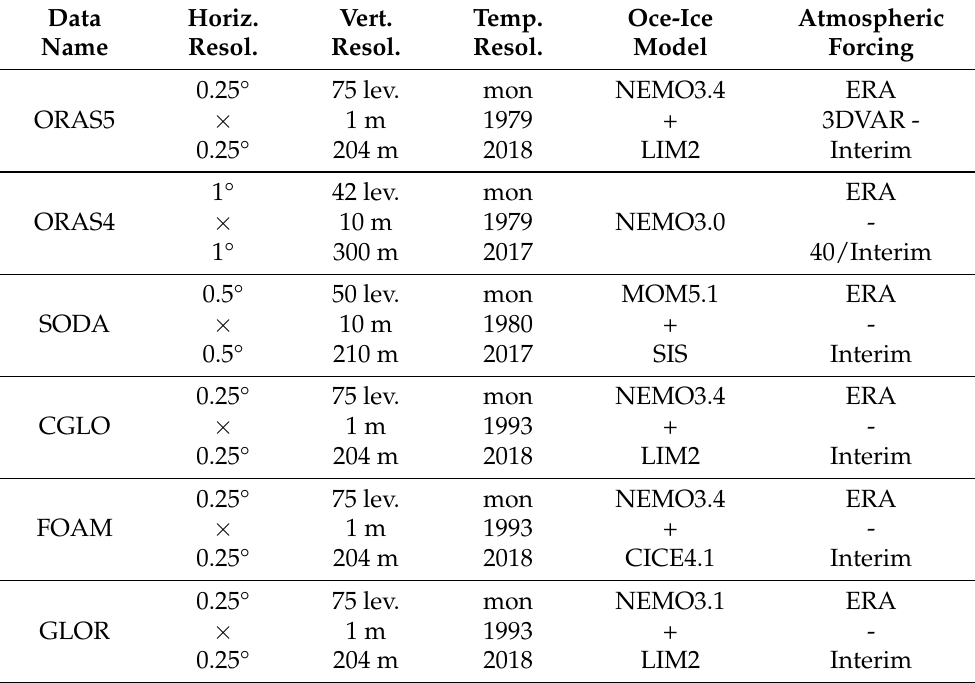
Table 1. Table highlighting the main differences across reanalyses: the vertical resolution column reports the number of level and the spacing of the first and the last level in